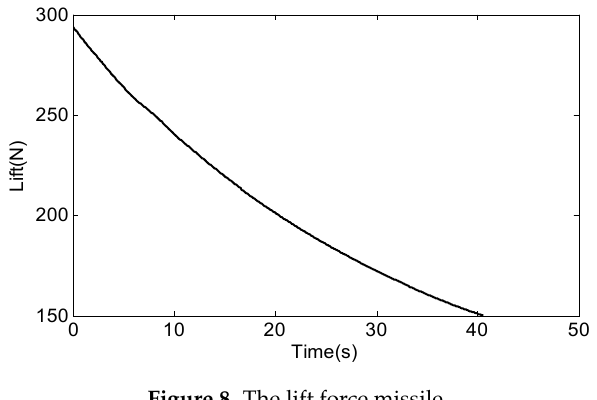
Figure 8. The lift force missile.